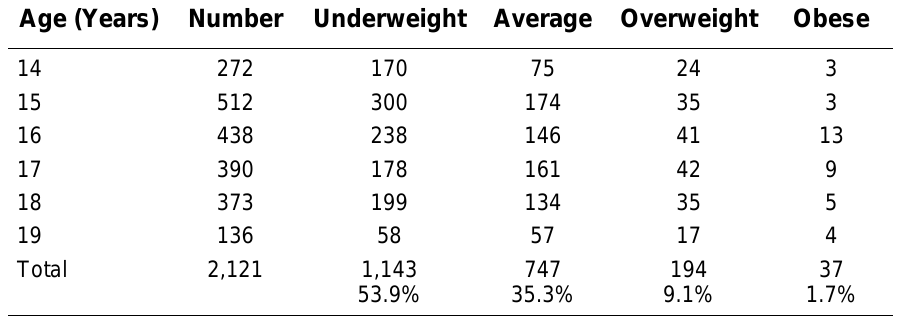
Participant Actual Body Size by BMI Classes, Corrected for Age and Italian Data[8,9]